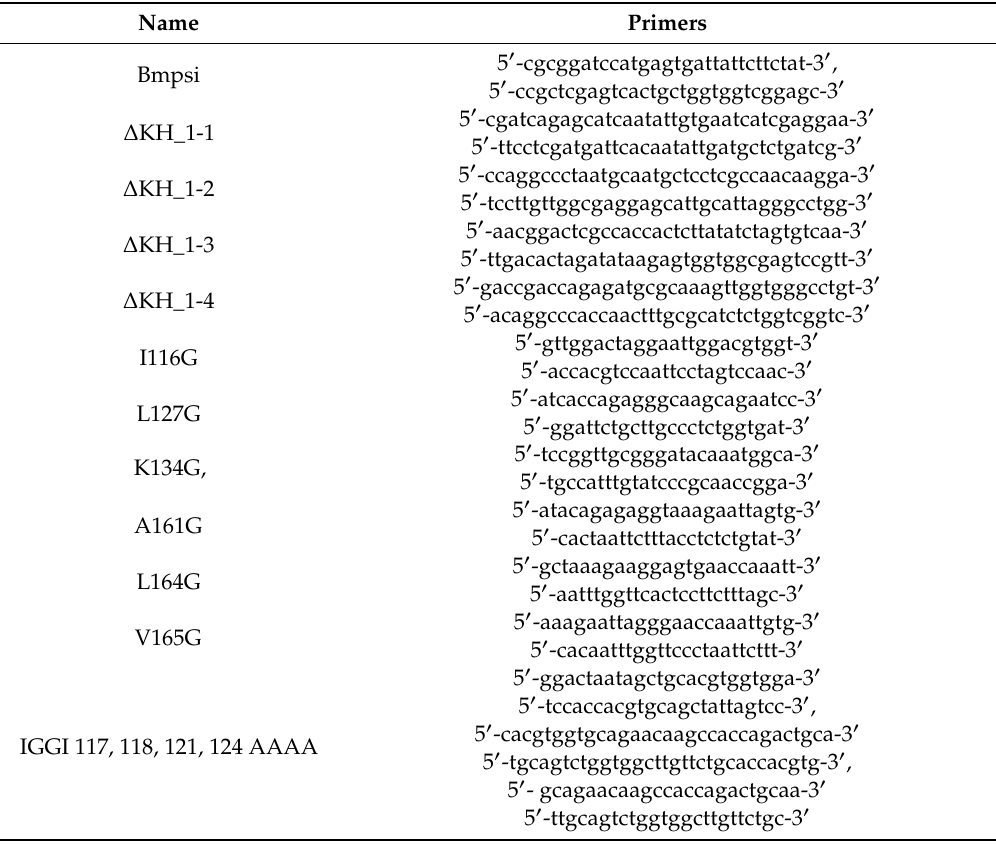
Table 2. Primer sequences of modifications on Bmpsi